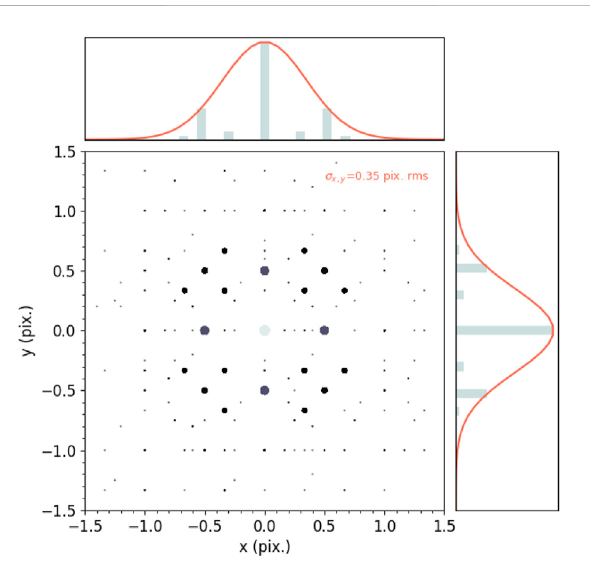
FIGURE 4 Statistical distribution of the distance of the fi ring pixels from the event centroid. Brighter color and bigger symbol dimension mean higher probability density values. On top and on the right-hand side, the x and y marginal distributions of the simulated data and of the two- dimensional Gaussian fi tting.